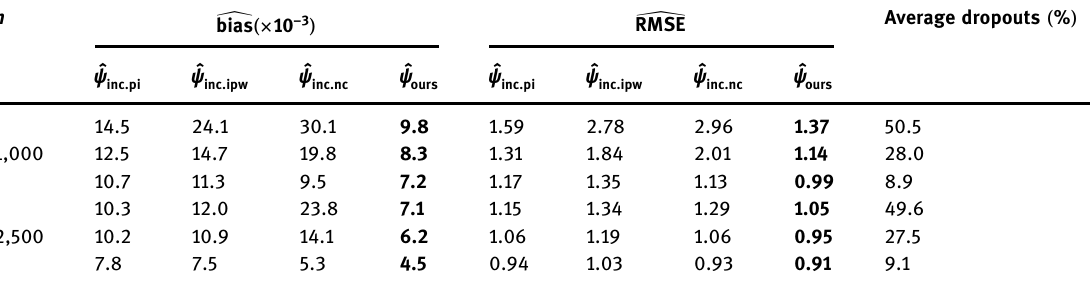
Table 1: Integrated bias and RMSE across di ff erent baselines and simulation settings. n bias 10 −3 (× ) ̂ RMSE ̂ Average dropouts ( % ) ψ ˆ